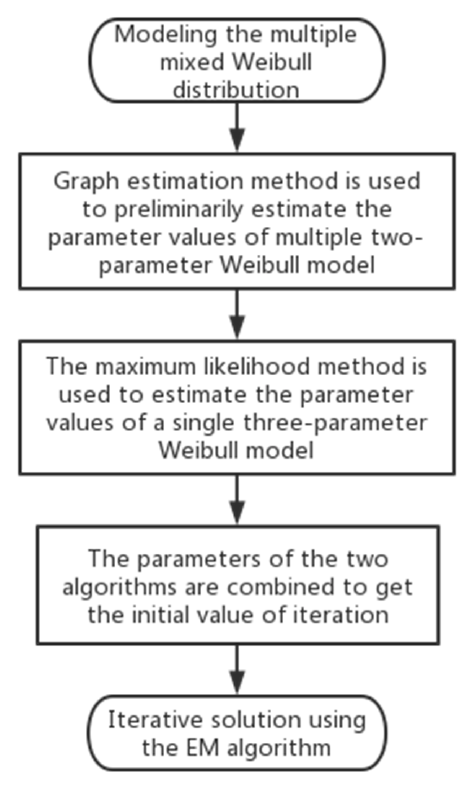
Figure 1. Flow chart of the EM optimization algorithm for the hybrid Weibull model.